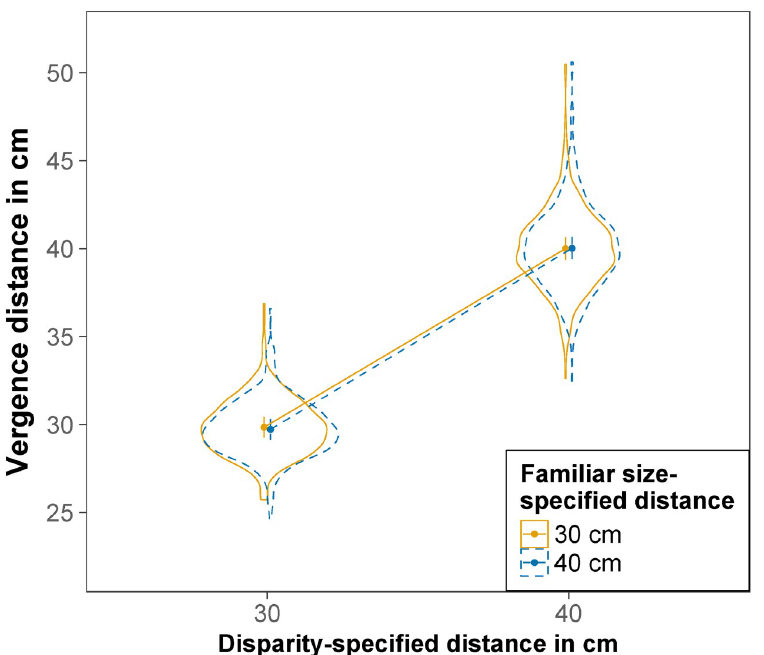
Fig 10. Vergence distance. Estimated marginal means of vergence distance for a binocular disparity-specified distance of 30 cm and 40 cm and a familiar size-specified distance of 30 cm (solid orange) and 40 cm (dashed blue). Error bars are model-based 95% confidence intervals indicating which values of the estimated means are likely and do not permit comparisons across repeated-measures factors [56]. Violin plots depict the distribution of the raw data.